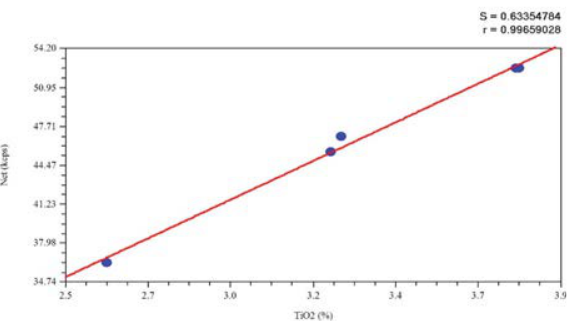
Figure 9. Calibration curve for the beads prepared by